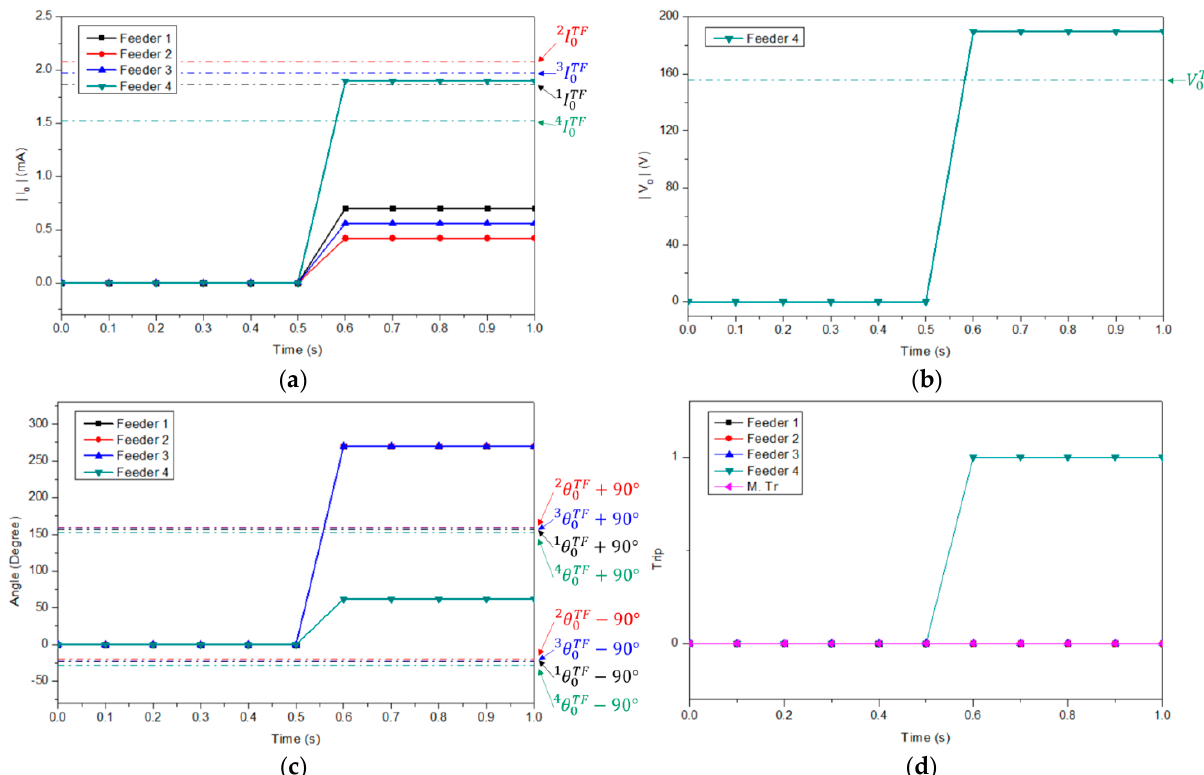
Figure 11. Test results for SLG faults in the fourth feeder with a fault resistance of 0 k Ω . ( a ) Zero-sequence current. ( b ) Zero-sequence voltage. ( c ) Zero-sequence angle difference. ( d ) Trip signal.